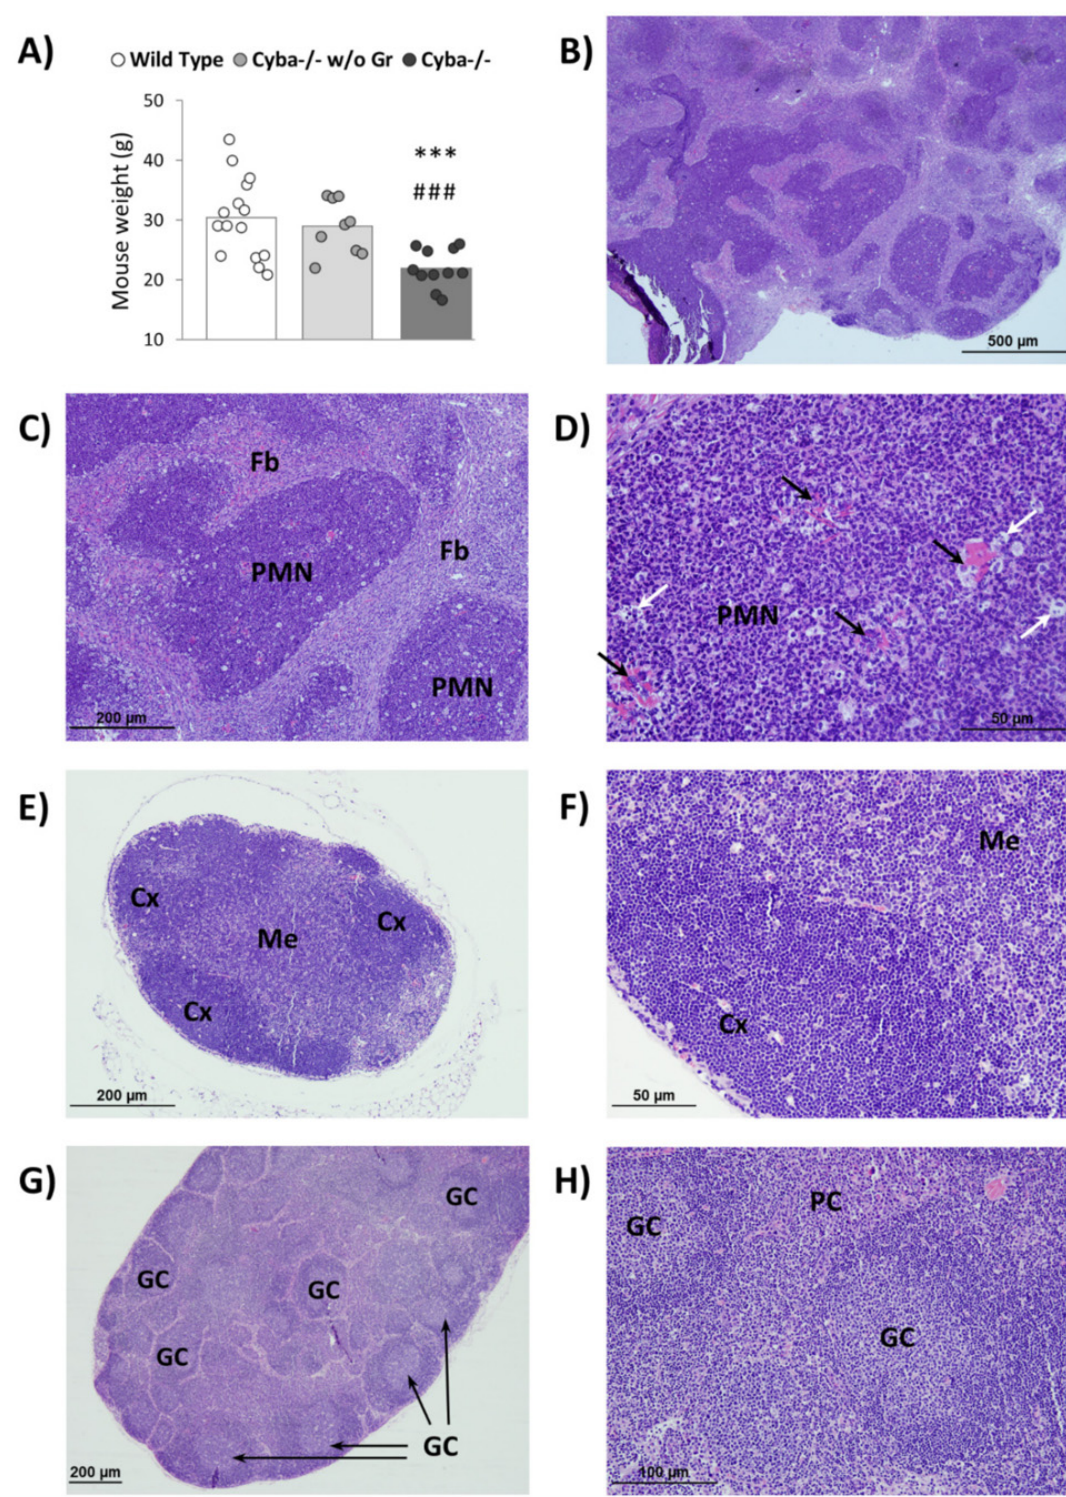
Figure 1. Cyba − / − mice spontaneously developed abscesses. ( A ) Difference in weight between wild-type (n = 15), Cyba − / − mice without granuloma ( Cyba − / − w/o Gr; n = 9) and granuloma-bearing Cyba − / − mice ( Cyba − / − ; n = 11). *** p < 0.001